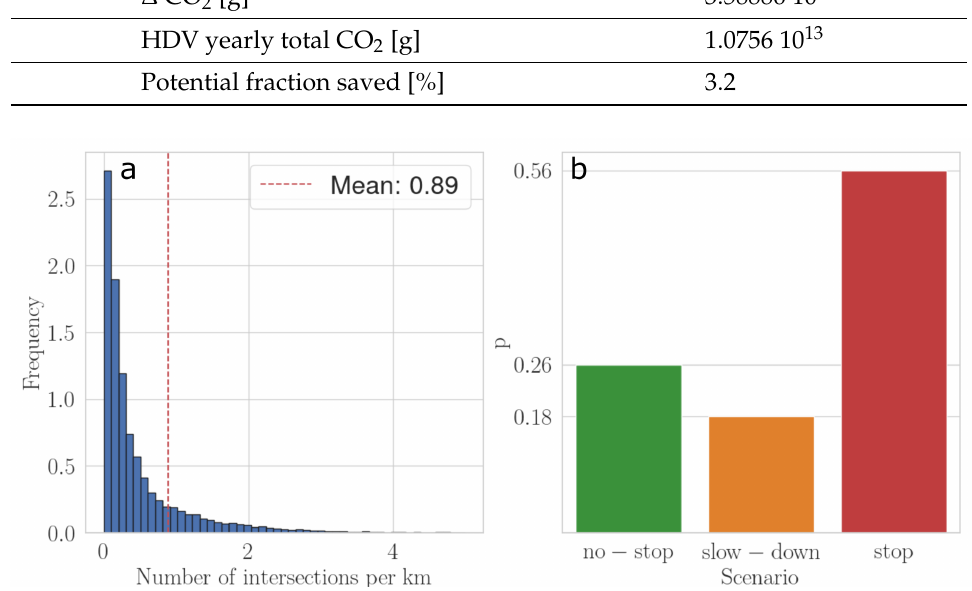
Figure 9. Values used to scale up the results to all the trips in the Netherlands. ( a ) The number of signalized intersections per km of road for each trip. The mean value, 0.89, represents the expectation value for the number of intersections found per km of road. ( b ) Shows the probabilities p i with i ∈ { no-stop,slow-down,stop } to find each of the three different behaviors when an HDV encounters a traffic